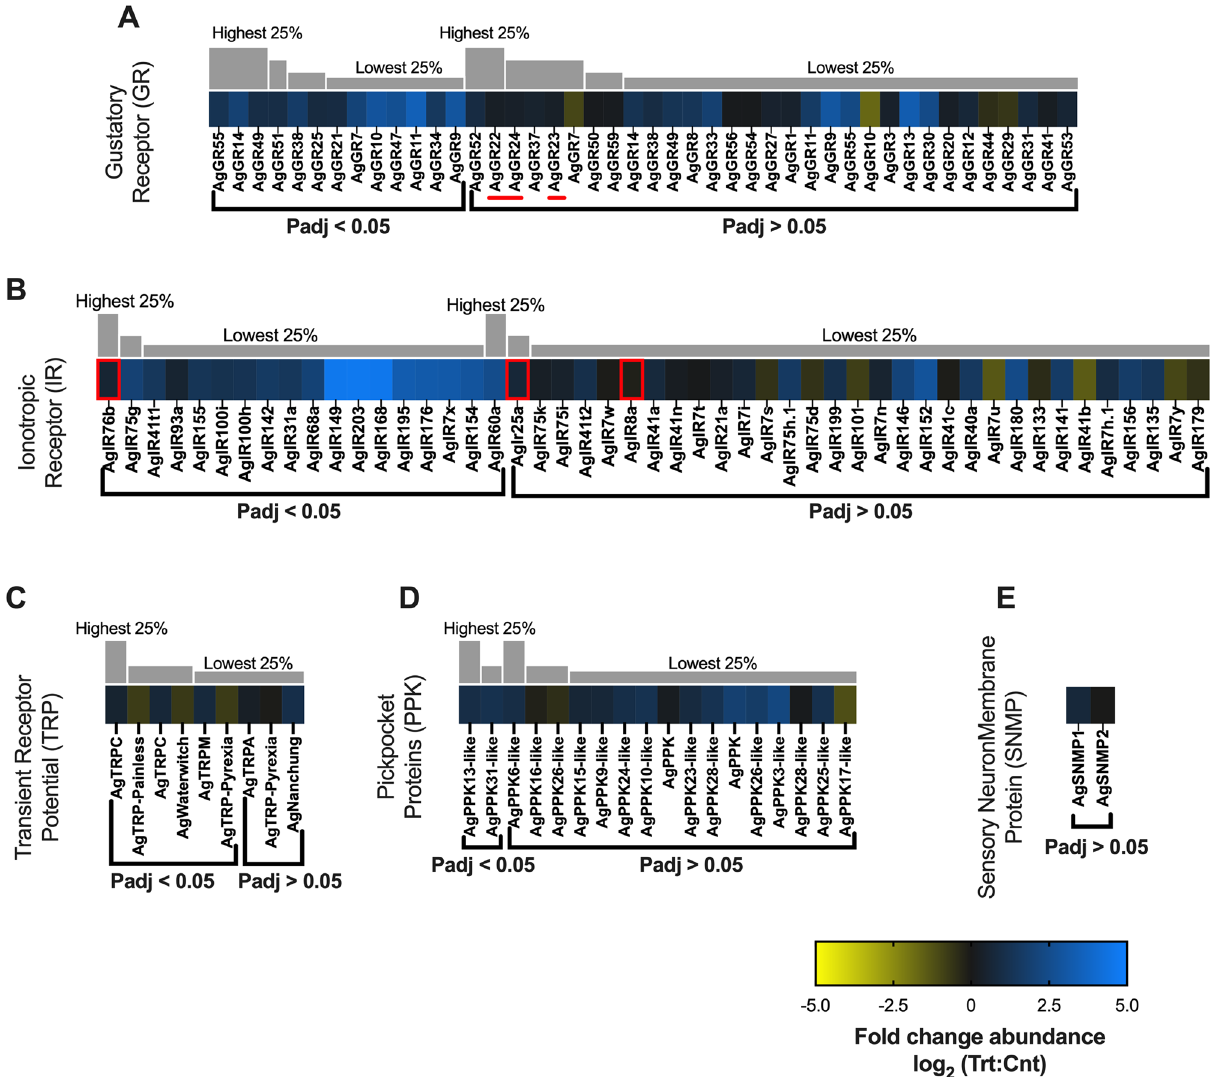
Figure 7. Chemosensory differential transcript abundances following relevant sporozoite infections. Chemosensory transcripts that were present at significantly higher (blue) or lower (yellow) levels in Plasmodium falciparum sporozoite infected treatments; non-differentially expressed chemosensory transcripts are denoted as zeros (black). Chemosensory genes within each family organized by adjusted p-value and subsequently arrayed left to right from most abundant to least abundant based on FPKM values (quartile bars above each image). ( A ) Gustatory receptor family (GR). ( B ) Ionotropic receptor family (IR). ( C ) Transient receptor potential family (TRP). ( D ) Pickpocket protein family (PPK). ( E ) Sensory neuron membrane protein family (SNMP). Chemosensory co-receptors are identified by red boxes. The three CO 2 gustatory receptors are identified by a red line. Log 2 scale indicates transcript abundances that were significantly higher (blue) or lower (yellow) in sporozoite infected treatments (Trt) vs. naïve controls abundant, AgGR11 (3.43-fold), and seven other AgGRs that are significantly more abundant in treatments remain unannotated, several AgGRs with homology to functionally characterized sugar-responding GRs from Drosophila display significantly higher transcript abundances than controls, suggesting a higher sensitivity to sugary sub- strates in treatments. These include the DmGR5a orthologs AgGR14 (1.94-fold; p-adj = < 0.001; AGAP006399) and AgGR21 (0.88-fold; p-adj = 0.05; AGAP003260); the DmGR43a ortholog AgGR25 (0.83-fold; p-adj = 0.05; AGAP004727); and the DmGR68a ortholog AgGR9 (2.90-fold; p-adj = < 0.0001; AGAP009805; Fig. 7A) 35 . It is reasonable to hypothesize that because glucose is the primary energy source for both mosquitoes and the Plasmodium sporozoites, it would be advantageous to manipulate its acquisition, uptake and transport, thereby synergistically supporting sporozoite and mosquito health, survival and by extension, malaria transmission 42,43 . This differential increase in putative sugar-responsive AgGRs as a consequence of salivary gland P. falciparum infections also correlated with a significant increase in the abundance of several sugar transporters (Supple- mentary Information). While this is the first identification of a P. falciparum -mediated increase in abundance